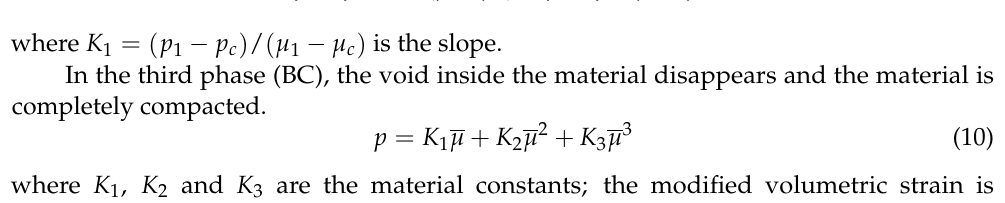
where K 1 = ( p 1 − p c ) / ( µ 1 − µ c ) is the slope. completely compacted.